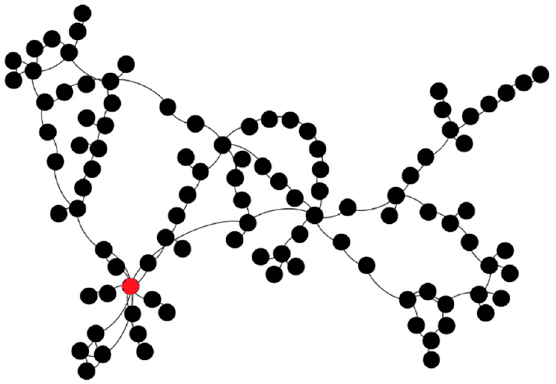
Figure 6. Location of the STW node in the graph that was first deleted.